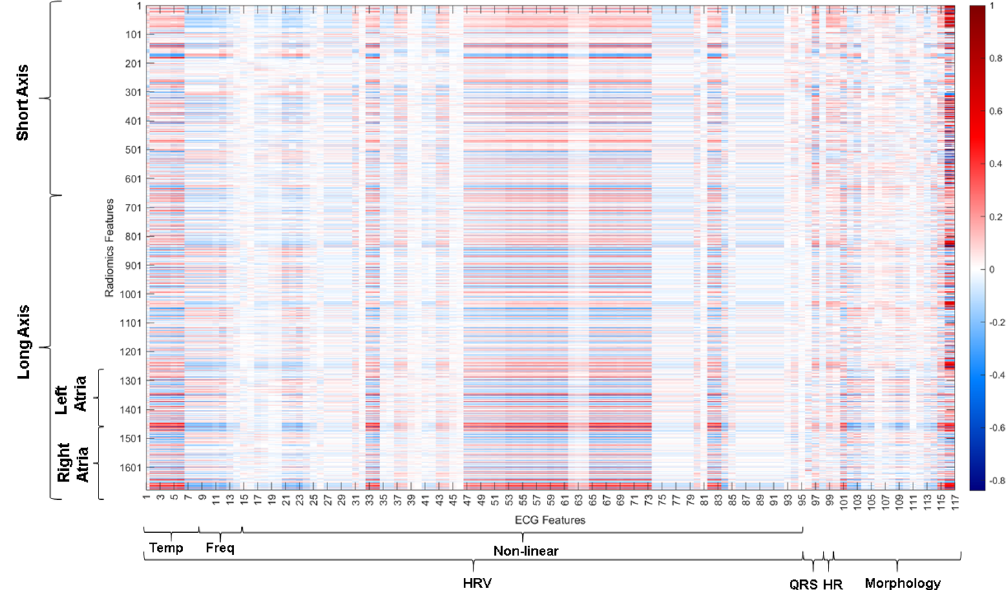
Figure 1. Correlation between ECG and radiomics features showing low correlation between radiomics features extracted from the short-axis images and a slightly higher correlation with the features from the long axis images including atrial metrics. Temp temporal, Freq frequency, HRV heart rate variability, HR heart